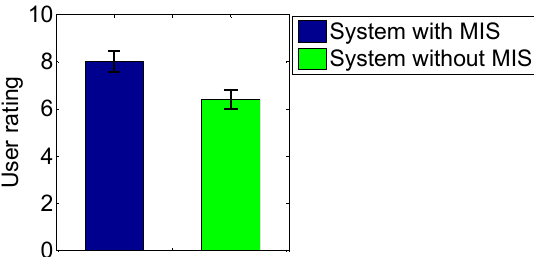
Figure 11. This graph shows the mean values of the user rating for the effectiveness of uncertain information evaluation of the systems in the two cases: system with MIS and without MIS. The error bars represent the standard